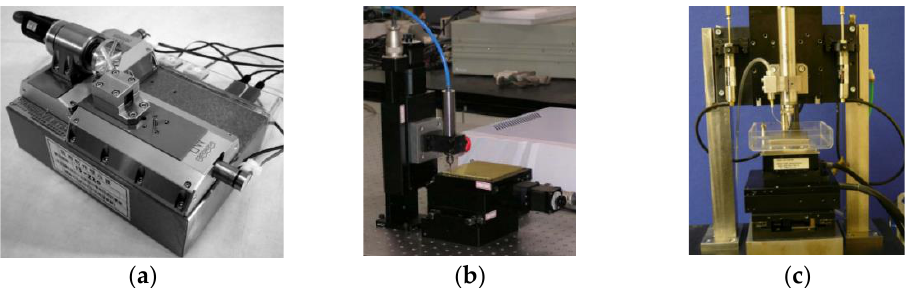
Figure 1. The prototype of the micro-cutting machine tool. ( a ) Micro milling machine(Japan) [11]. ( b ) Micro milling machine (Korea) [11]. ( c ) Micro milling machine (UK) [12].